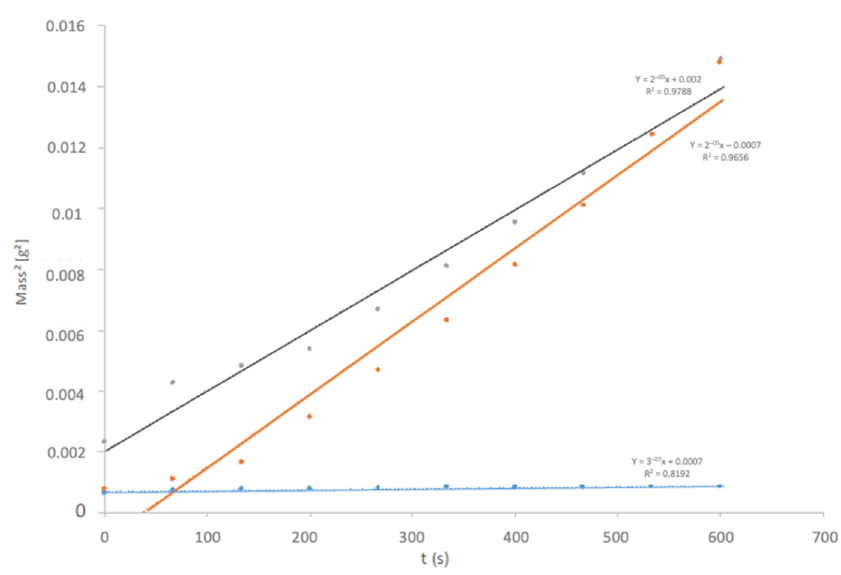
Figure 5. Representation of the sorption (mass increase as a function of time) of several samples of